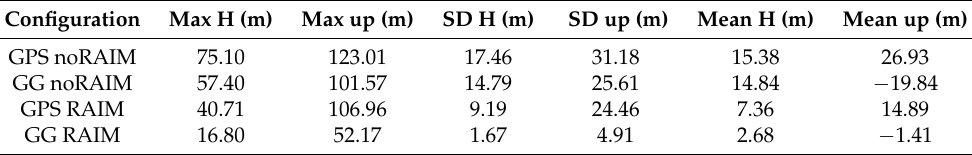
Table 5. Position error statistics considering only common reliable